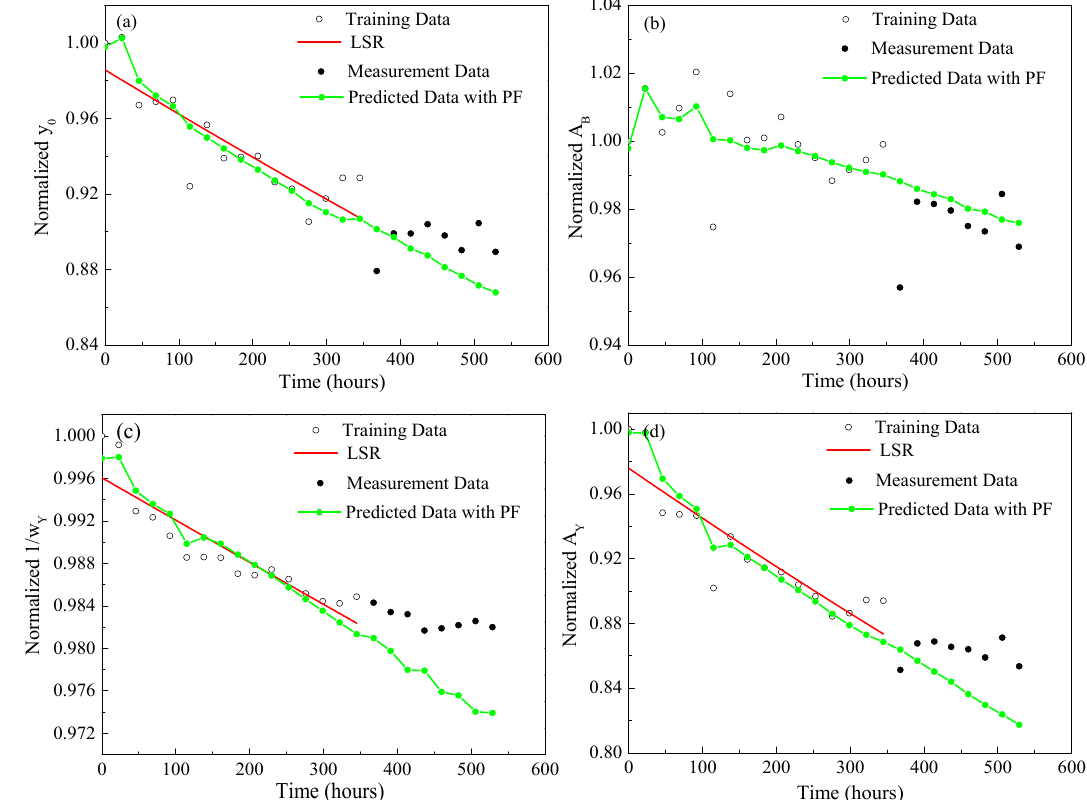
Figure 12. PF prediction results of four normalized features extracted from the Lorentzian model until 529 h ( a ) Normalized y 0 ; ( b ) Normalized A B ; ( c ) Normalized 1/ w Y ; ( d ) Normalized A Y .